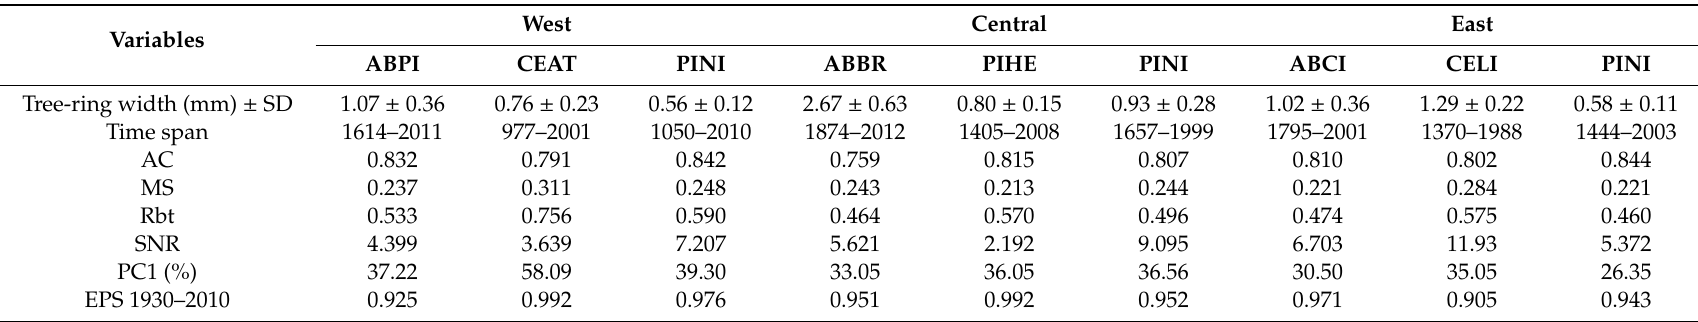
Table 3. Dendrochronological statistics based on radial growth series for each studied site. The statistics and mean basal tree-ring width values were calculated for the common period of 1930–2010. All dendrochronological statistics were calculated for residual series except autocorrelation (AC), which was obtained for raw tree-ring width